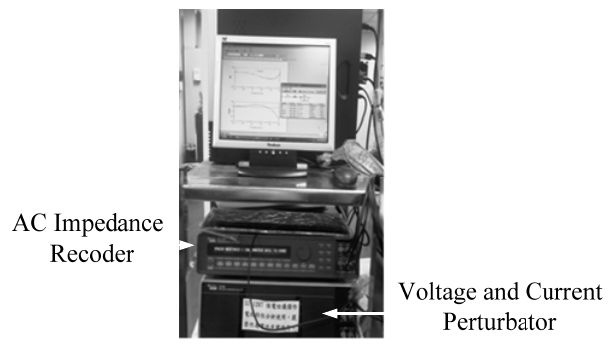
Figure 13. The AC impedance analyzer.